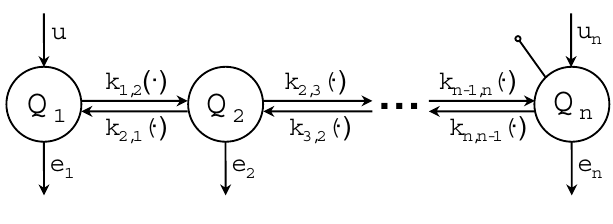
Fig. 1. Diagram of a compartmental in-series